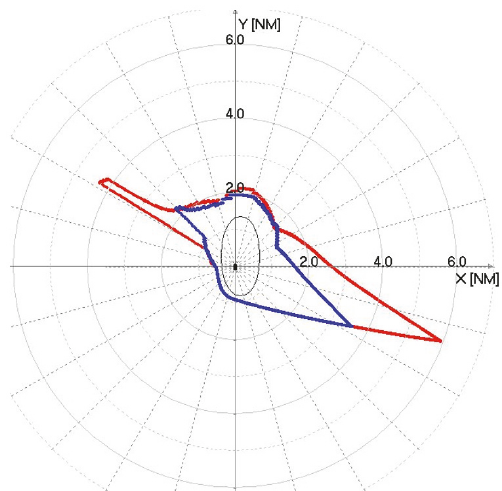
Figure 30: Action lines for stand-on encounterwith a target, whose true speed is 18 knots. Manoeuvres to both sides are considered, but they are limited by risk of successive high wave attack and resonance. Wind of 17 [m/s] and wave from 0 ∘ (blue) and 260 ∘ (red) are assumed.